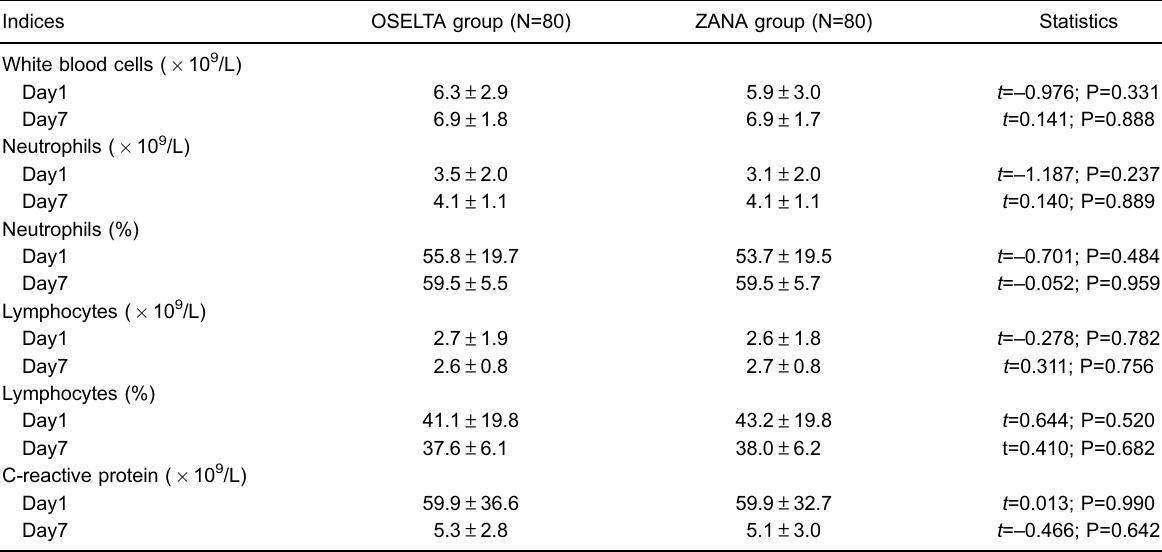
Table 4. Comparison of blood test parameters before and after treatment with oral oseltamivir (OSELTA group) or inhaled zanamivir (ZANA group) of chronic obstructive pulmonary disease patients with in fl uenza virus infection. Indices OSELTA group